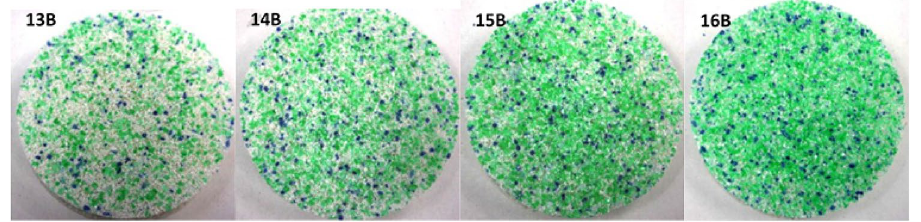
Figure 12. Pictures of side B of samples 13 to